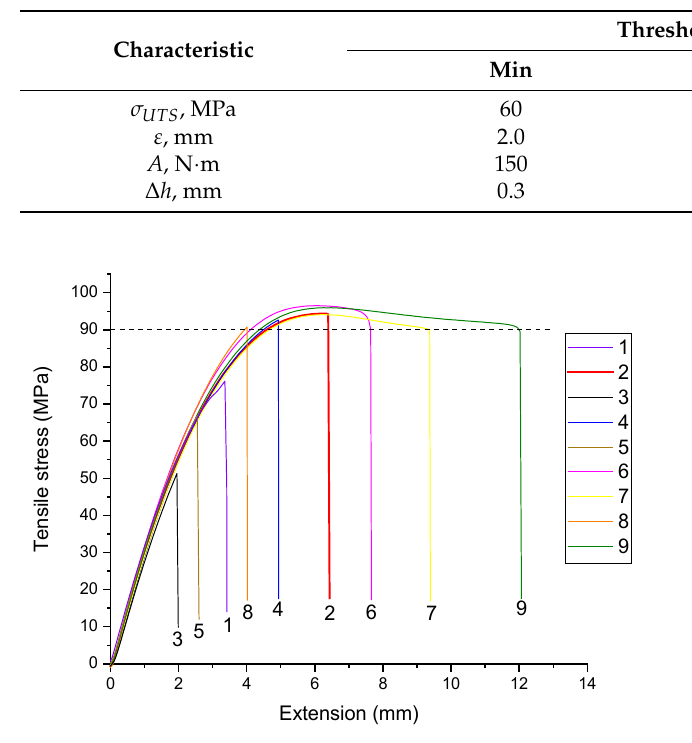
Figure 6. Stress–strain diagrams for the studied USW joints.